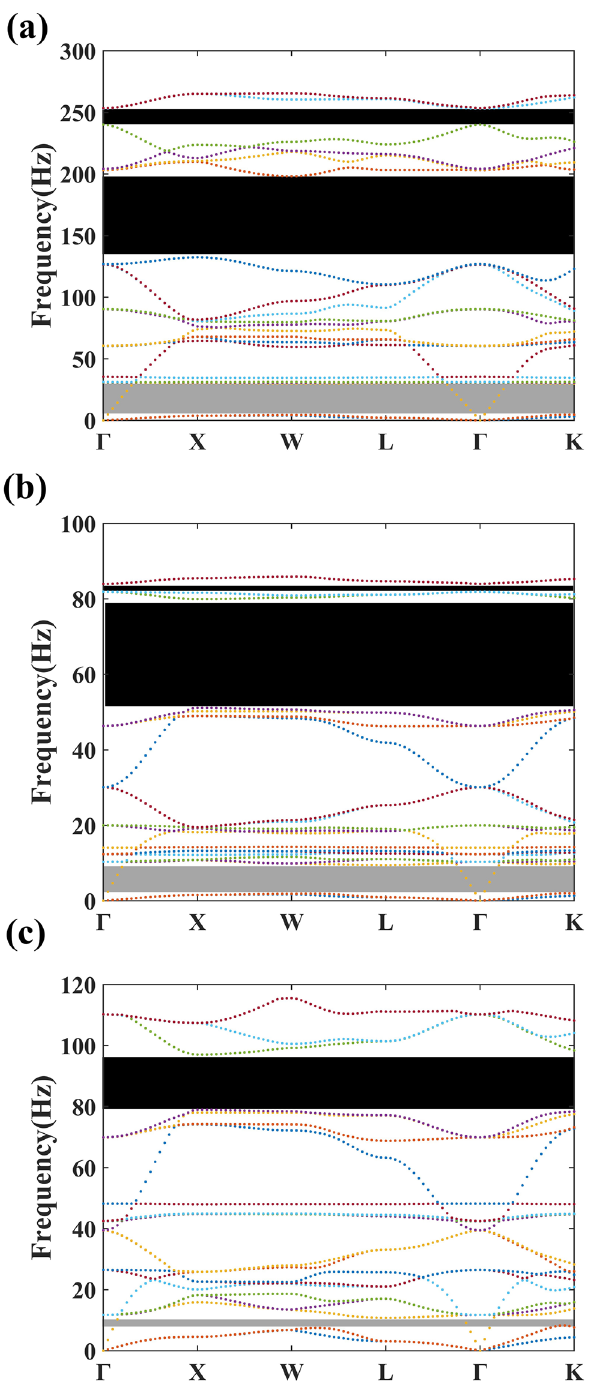
Figure 2. The phononic band structure of locally resonant PMs composed by ( a ) S1, ( b ) S2, ( c )